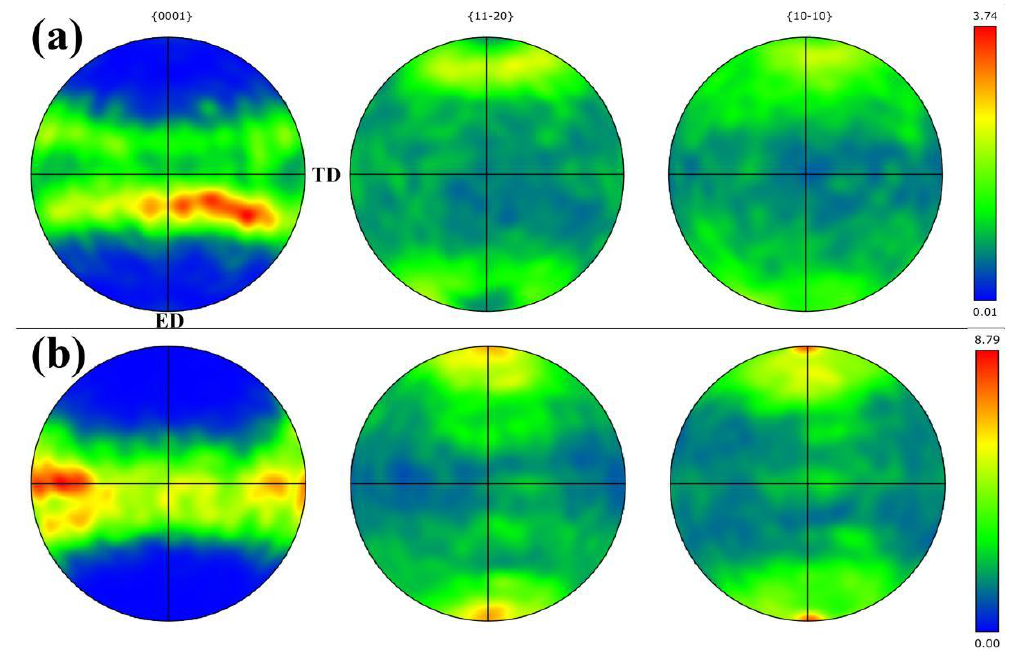
Figure 7. { 0001 }, { 112̅0 } and { 101̅0 } PF of as-RS ( a ) and as-homogenized ( b ) AZ31 hot-extruded rods. Figure 7. {0001}, {1120} and {1010} PF of as-RS ( a ) and as-homogenized ( b ) AZ31 hot-extruded rods.